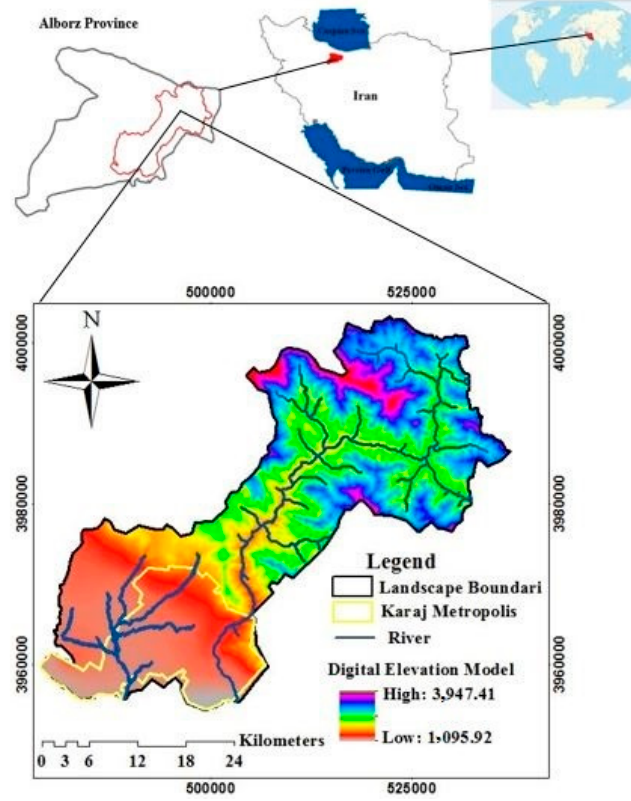
Figure 1. Location of the study area.